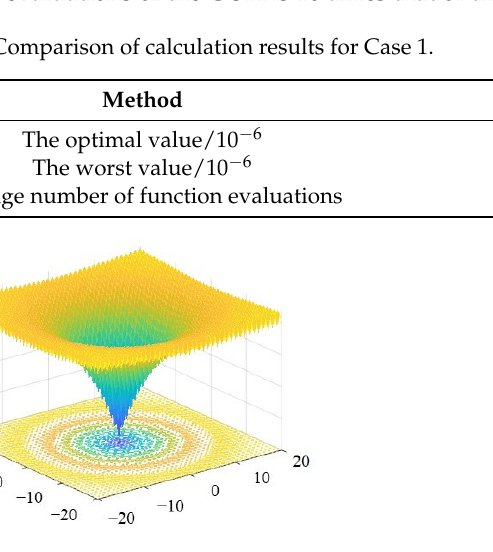
Figure 4. Three ‐ dimensional space surface diagram of Case 1.